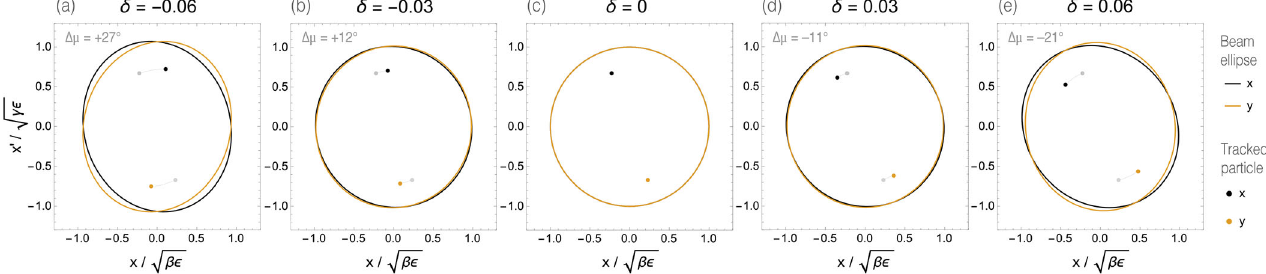
FIG. 3. Phase space plots with beam ellipses and a single tracked particle for several energy offsets δ , after transport through the first order apochromatic lattice shown in Fig. 2(b). As the energy increases [ ð a Þ → ð e Þ ], the particle experiences less phase advance ( Δ μ ), indicating a nonzero chromaticity ξ < 0 as defined by Eq. (2). However, since the distribution of particles retains the same shape around nominal energy [(b) and (d)], β and α are unchanged to first order and therefore chromatic amplitude W ¼ 0 . At larger energy offsets [(a) and (e)], the ellipse is distorted due to higher order